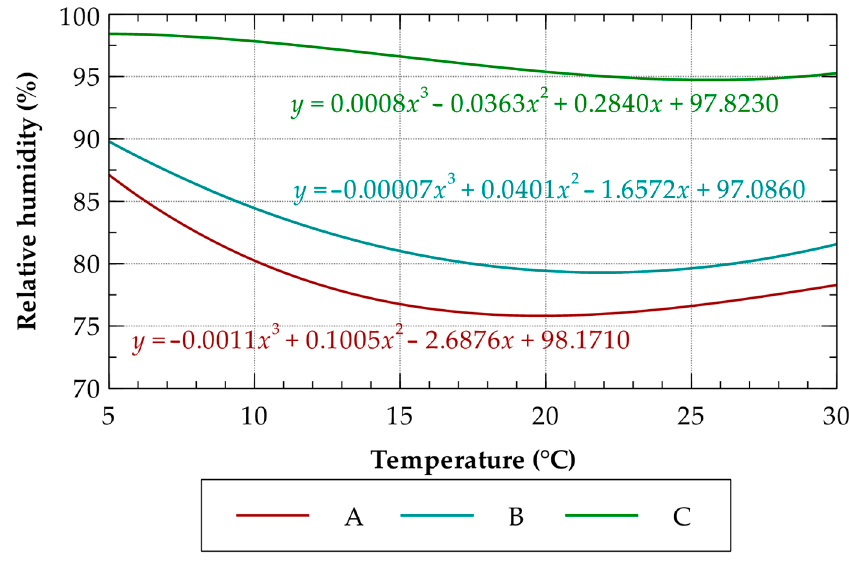
Figure 5. Favorable growth conditions.